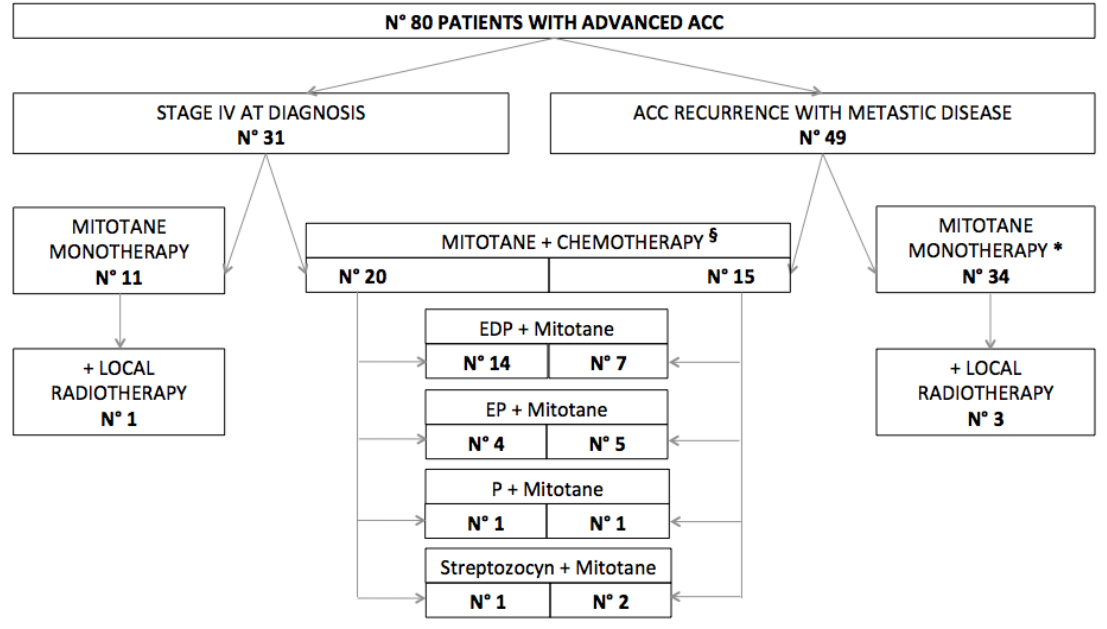
Figure 2. Management of advanced adrenocortical carcinoma (ACC)in our series. * 17 patients were